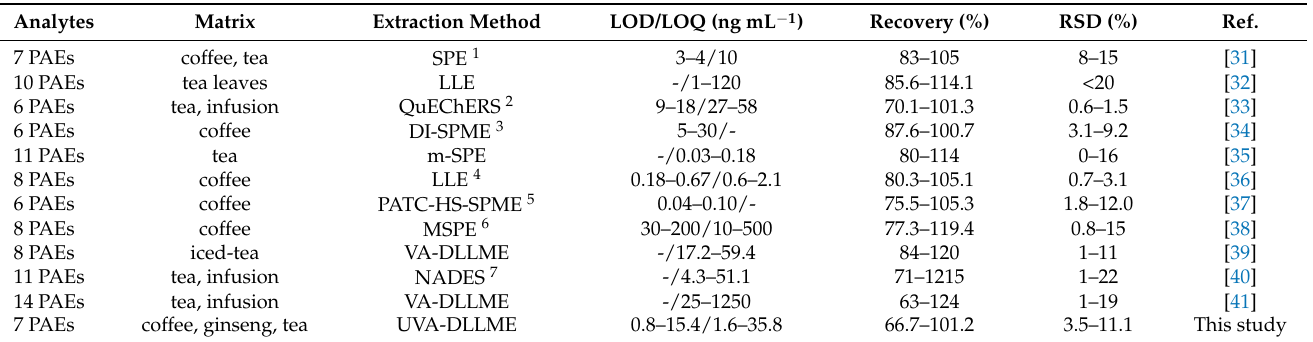
Table 8. Comparison between the method developed in this paper and some reported in literature on the same matrices (-: data not reported).